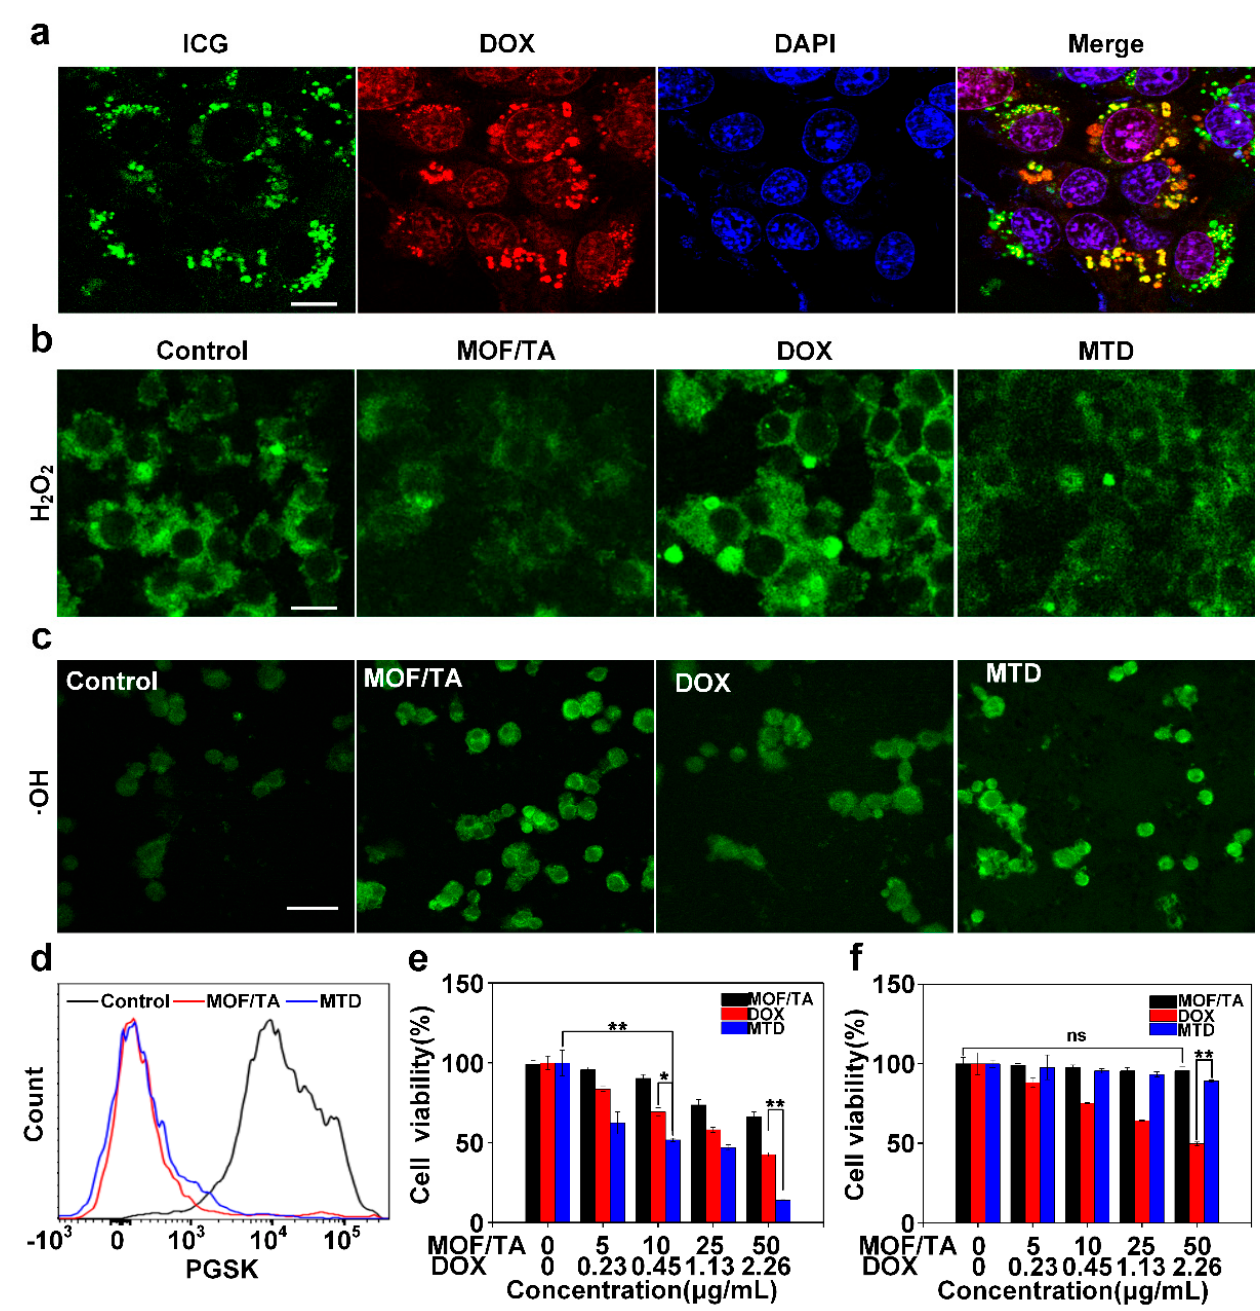
Figure 3. In vitro chemo/chemodynamic therapy effect: ( a ) CLSM images of MTD internalized be- havior. Scale bar, 10 µm; ( b ) CLSM images of cellular H 2 O 2 content after different treatments.